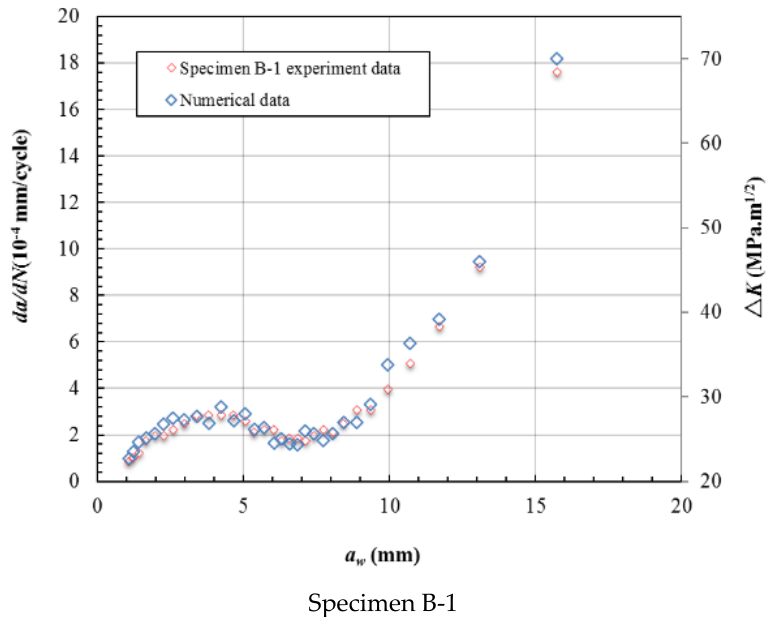
Figure 23. The crack growth rate and Δ K varying with the crack length a w.